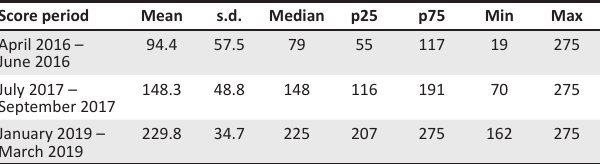
TABLE 1: Median scores against the standard mentorship (April 2016 – Sep 2017) and the intensified mentorship approaches (Oct 2017 – Mar 2019) for University of Maryland, Baltimore-supported laboratories in Kenya.